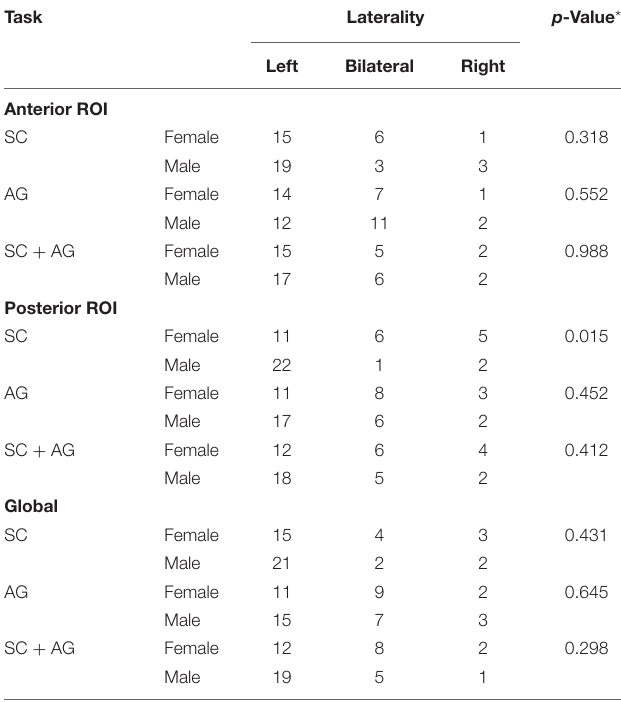
TABLE 4 | Lateralization index results within the language ROI in the dominant hemisphere. Task Laterality p -Value